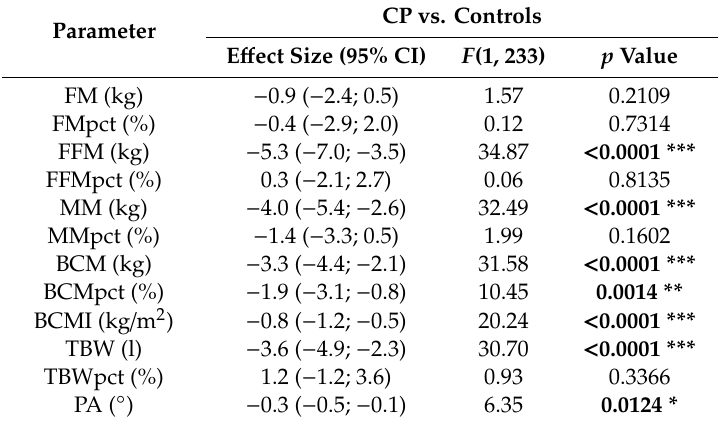
Table 2. Comparison of BIA results in study and control groups—estimation of di ff erence between CP and controls using ANCOVA model with age as covariate.